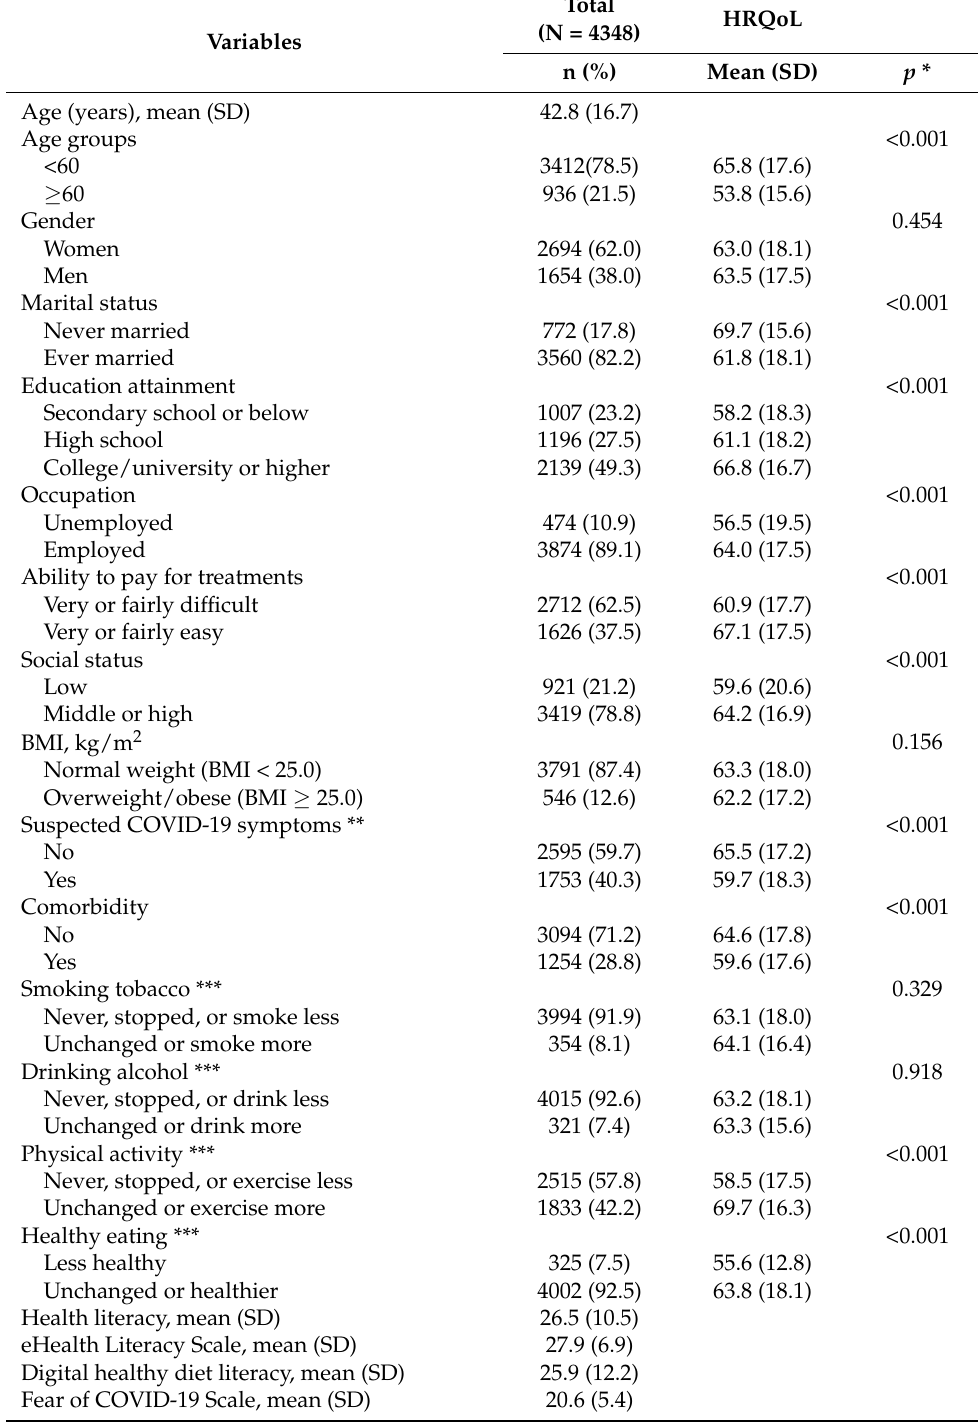
Table 2. Characteristics and health-related quality of life among outpatients (N =